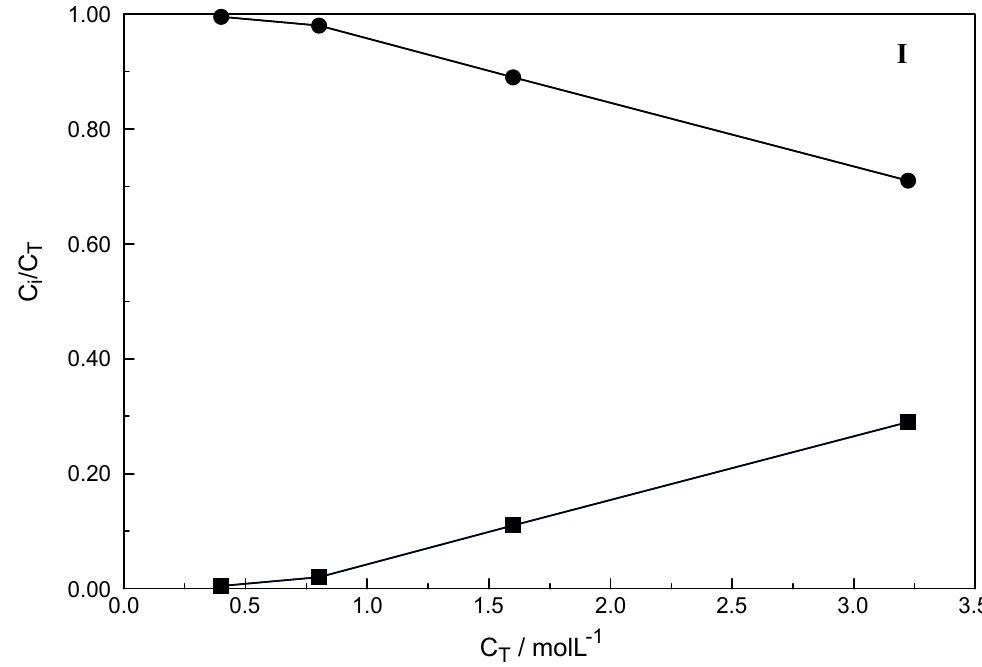
Figure 7. Fraction of species detected by quantitative Raman spectroscopy. The filled circles denote the [Yb(OH 2 ) 8 ] 3+ , the fully hydrated Yb 3+ and the filled squares the mono chloro-complex species, [Yb(OH 2 ) 7 Cl] 2+ . Note the error bar in the right corner of the graph. The formation of a 1:1 complex with Cl - at higher YbCl 3 concentrations may be written as: The estimated K 1 value for chloro complex formation in YbCl 3 (aq) from K 1 details) equal to ca. 0.06 ± 0.015 and a logK 1 value at ca. − 1.22 follows at 22